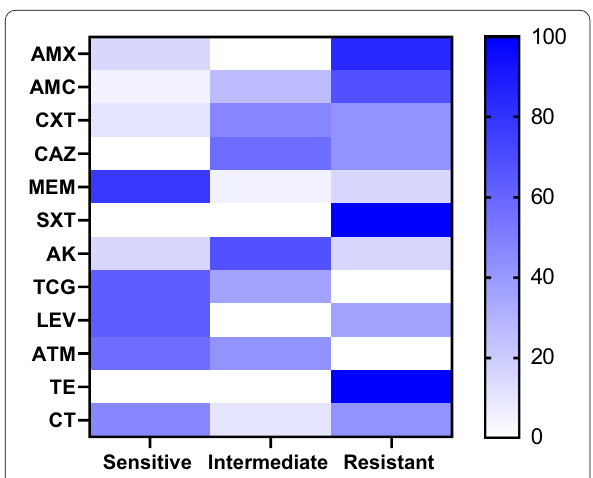
Fig. 1 The heat map describes the susceptibility of the recovered E. coli isolates to various tested antimicrobial